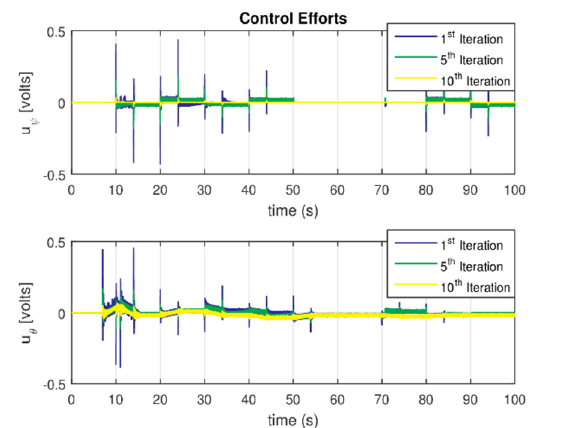
Fig. 8: Control Efforts at different Iterations using Hybrid ILC